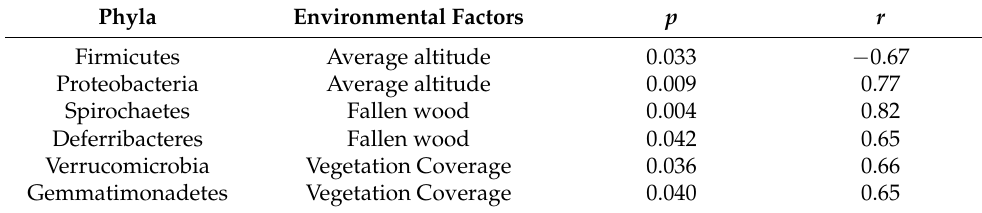
Table 2. Correlation analyses between phyla relative abundance and environmental factors. Phyla Environmental